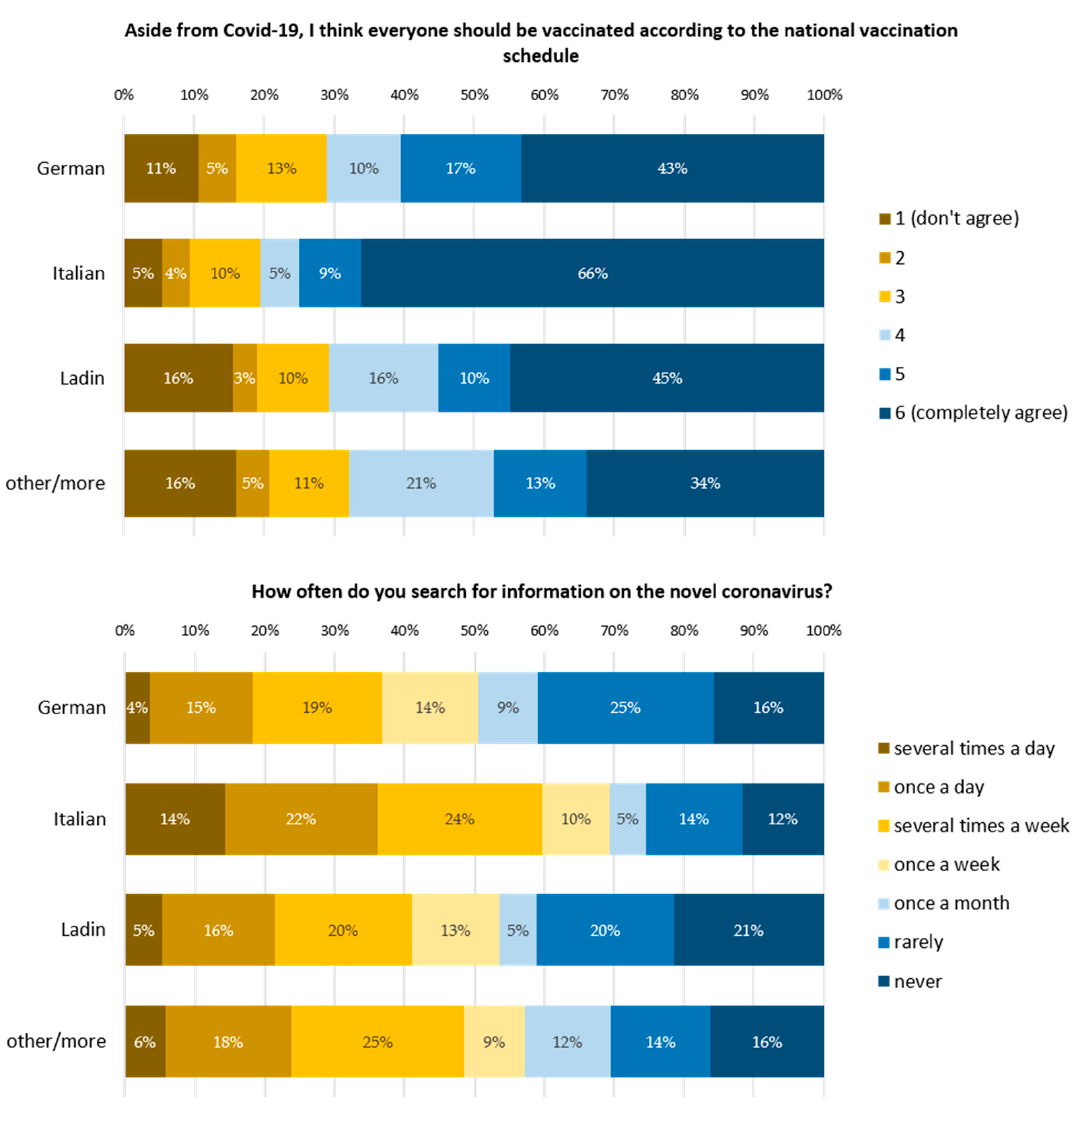
Figure 4. Attitudes towards national non-COVID-19 vaccination schedules (upper panel) and fre- quency of searching for coronavirus information related to native language group membership (lower panel). Upper panel: German vs. Italian, p < 0.001; Italian vs. other/more, p < 0.001; Italian vs. Ladin, p = 0.05; Italian vs. other/more, p < 0.001. Lower panel: German vs. Italian, p < 0.001; Italian vs. Ladin, p = 0.001; Italian vs. other/more, p = 0.028. P-values indicate Bonferroni-corrected signifi- cant differences from pairwise Mann–Whitney test after Kruskal–Wallis test (N = 1425). Both Krus- kal–Wallis tests were significant, with p < 0.001.